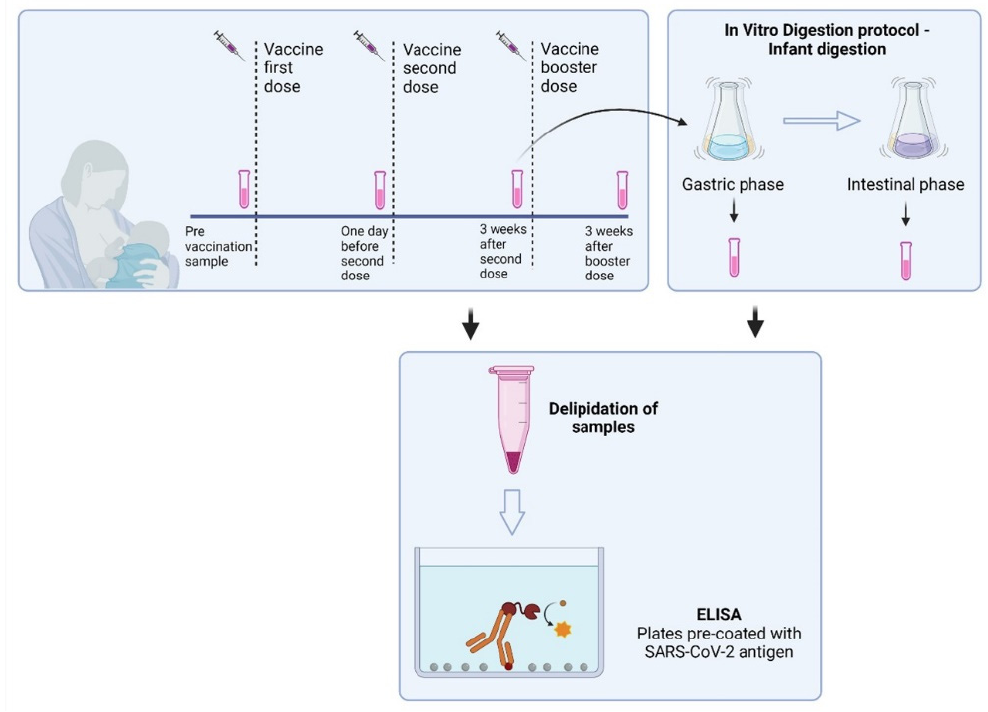
Figure 1. Overview of the study